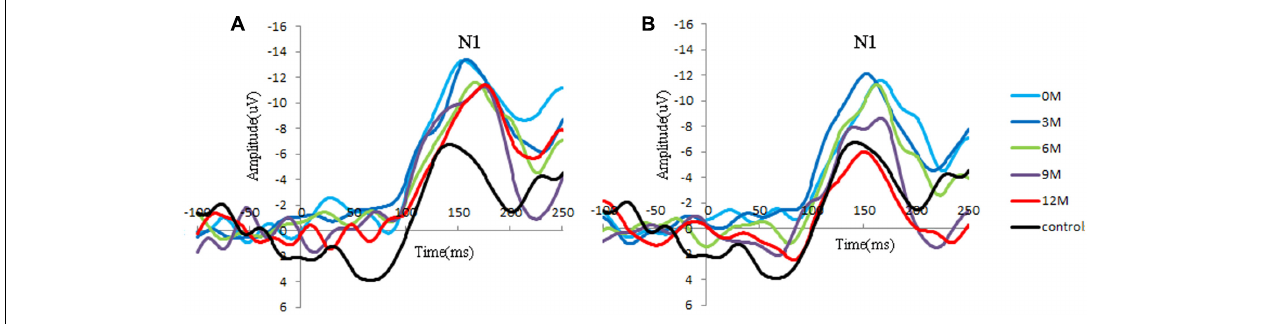
FIGURE 2 | Group-averaged cortical changes of N1 components in CI children and controls. (A) Poor CI performers (PCP) and controls; (B) good CI performers (GCP) and controls. N1 is a negative response around 150 ms post-stimuli, and the peak amplitude is determined by the most negative point around 130–170 ms for each participant.